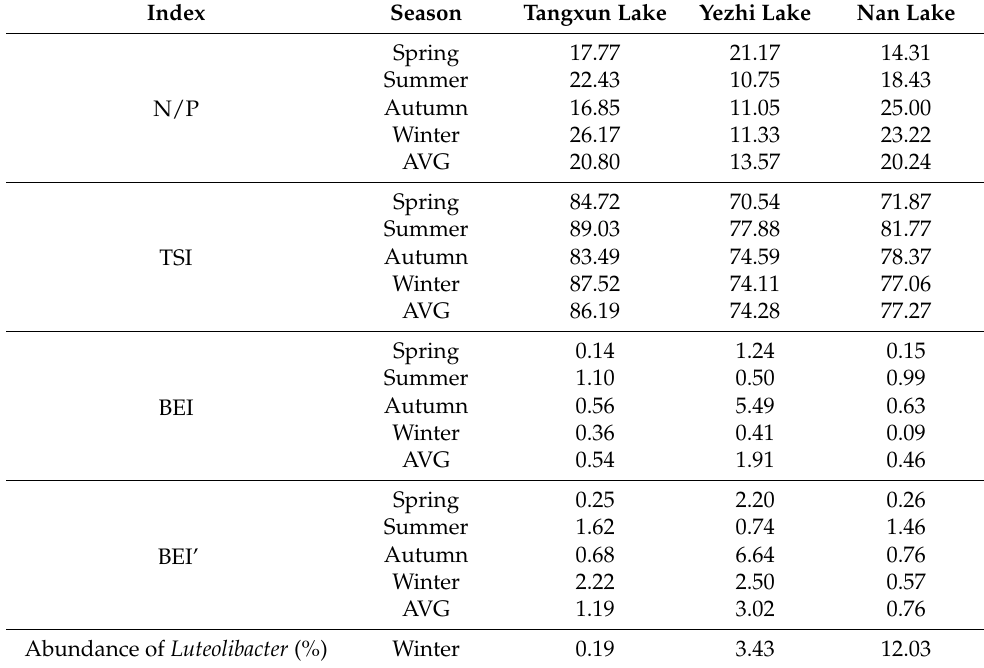
Table 3. Eutrophic index of the three lakes in different